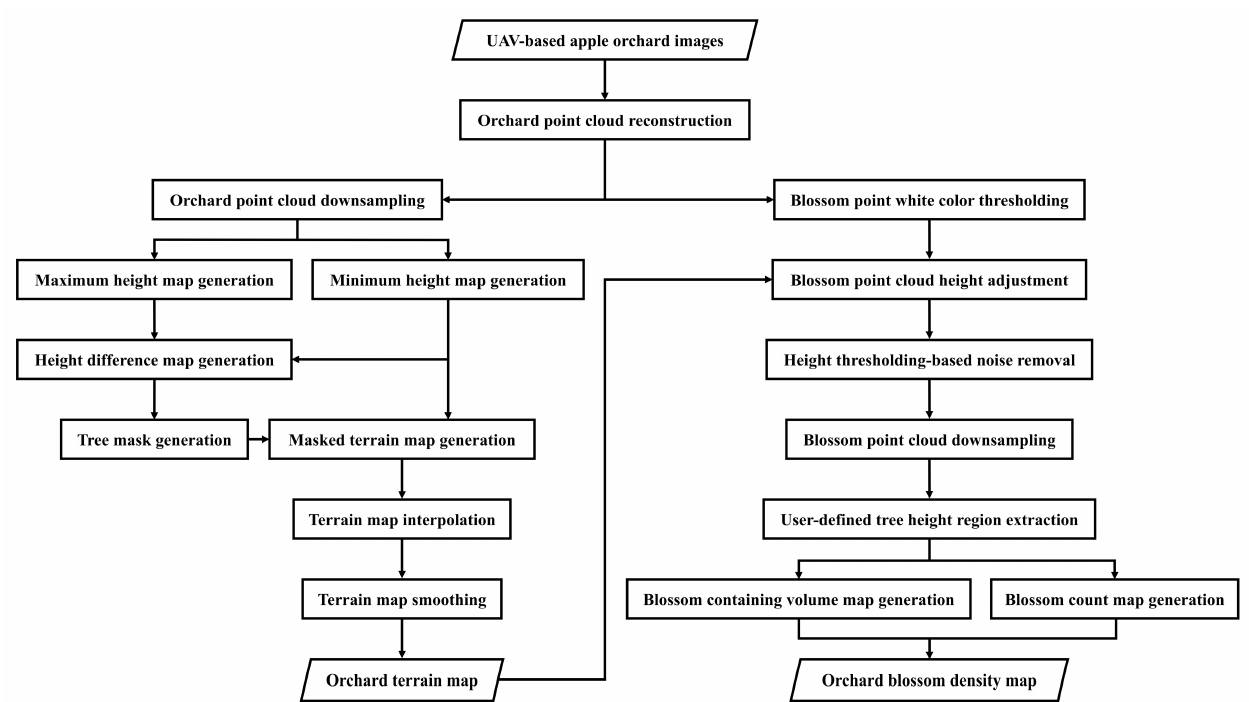
Figure 1. Schematic flowchart of the proposed apple orchard blossom density mapping